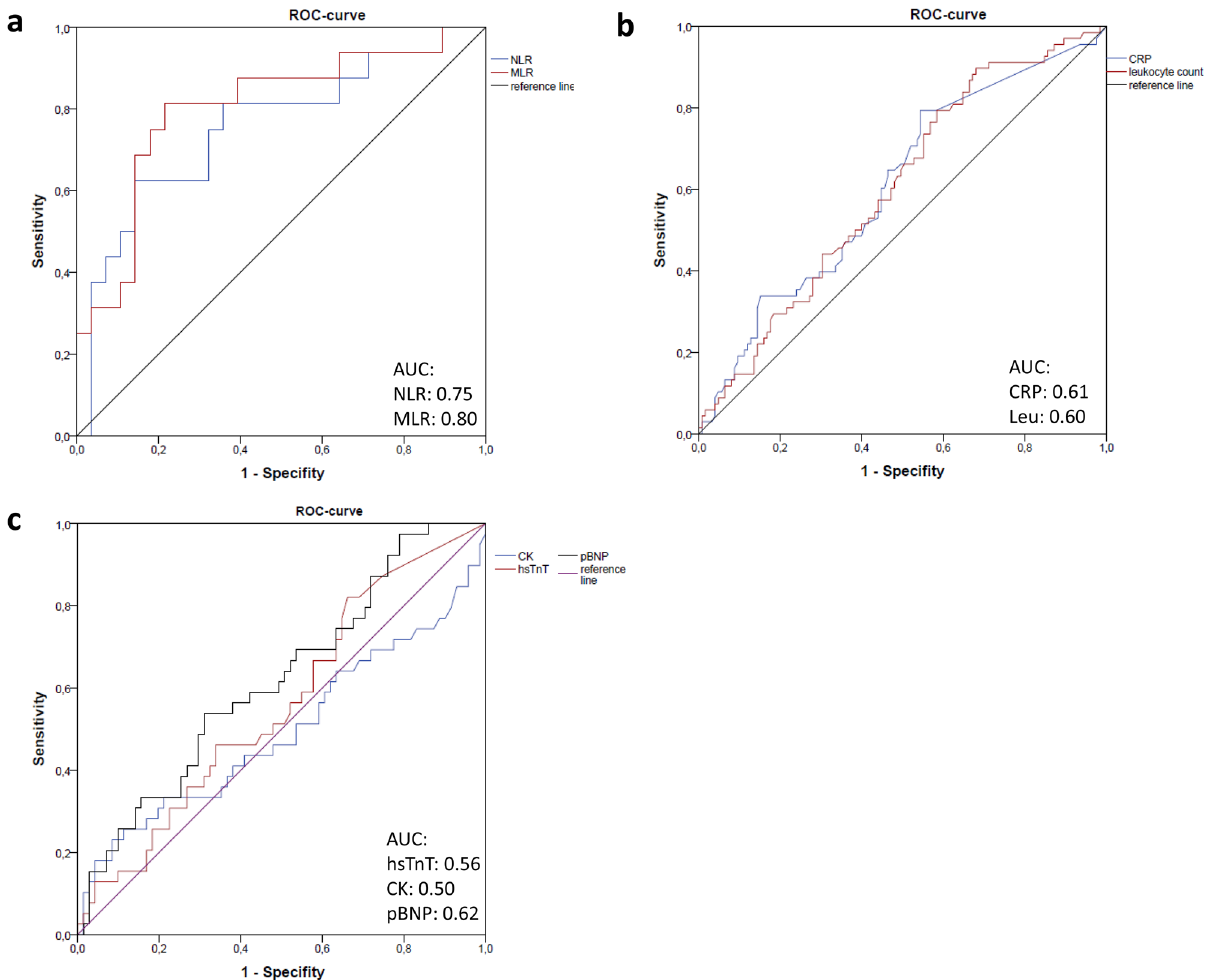
Figure 2. ROC-curves for prolonged hospital stay (≥ 7 days) of ( a ) NLR and MLR, ( b ) CRP and leukocyte count, ( c ) hsTnT, CK, pBNP. Abbreviations: NLR = neutrophil-to-lymphocyte ratio, MLR = monocyte-to- lymphocyte ratio, CRP = C-reactive protein, hsTnT = high sensitivity troponin T, CK = creatinine kinase, pBNP = pro brain natriuretic